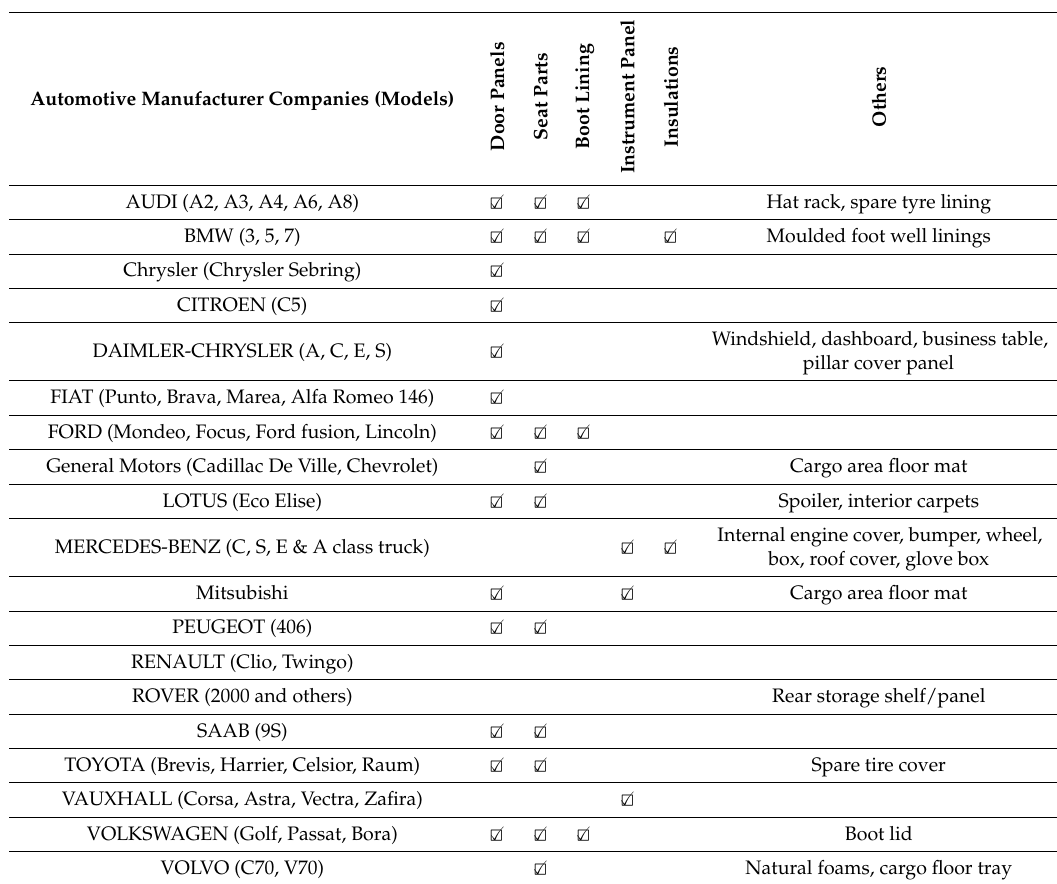
Table 9. Natural fibre-based parts in different models of several automotive manufacturers. Adapted from: [11,99,100].